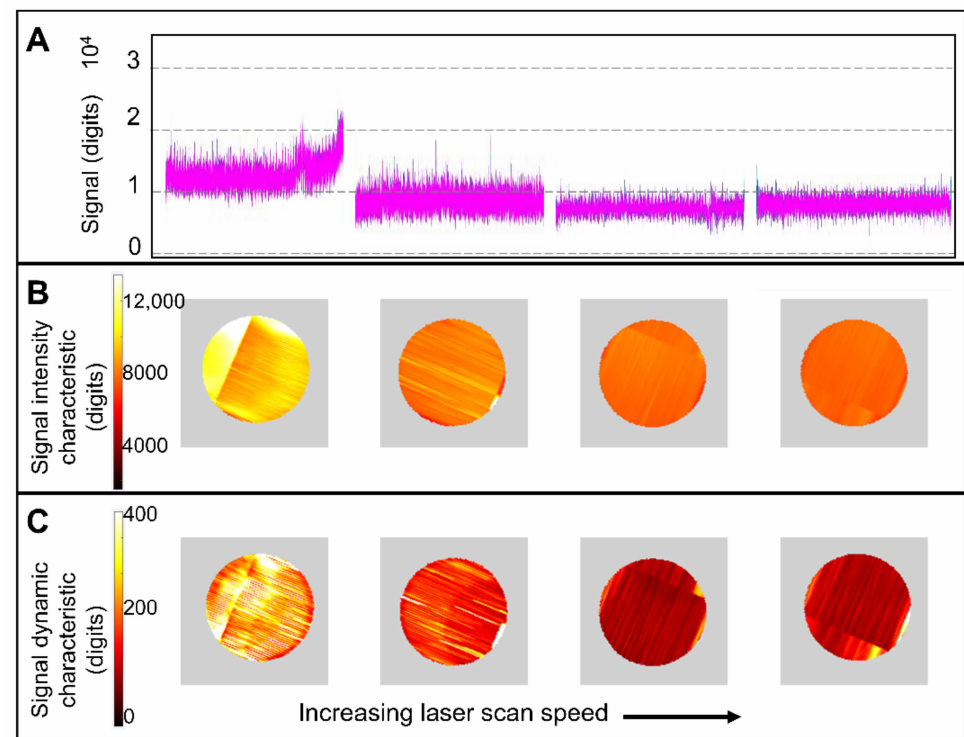
Figure 3. Representative sample of melt pool monitoring of specimens with increasing laser scan speed in the keyhole regime, sampled from the topmost layer of each specimen. Laser scan speed of 200 mm/s, 400 mm/s, 600 mm/s, and 800 mm/s and otherwise identical parameters (nominal laser power 200 W and layer thickness 40 µ m). ( A ) Raw signal in temporal x-coordinate. ( B ) The signal intensity characteristic is the output of a smoothing operation and translation to spatial